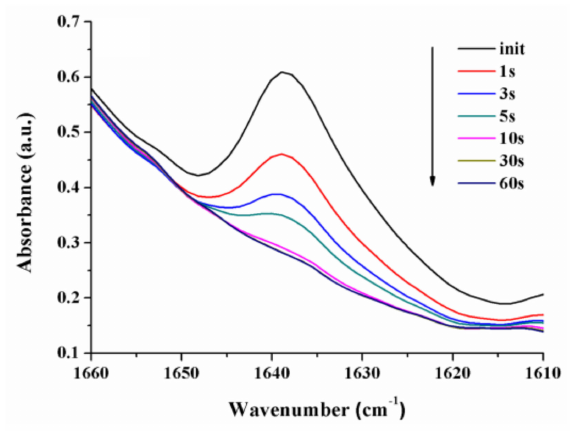
Figure 5. Modification of the double bond FTIR absorption band for L1 formulation during the irradiation with UV